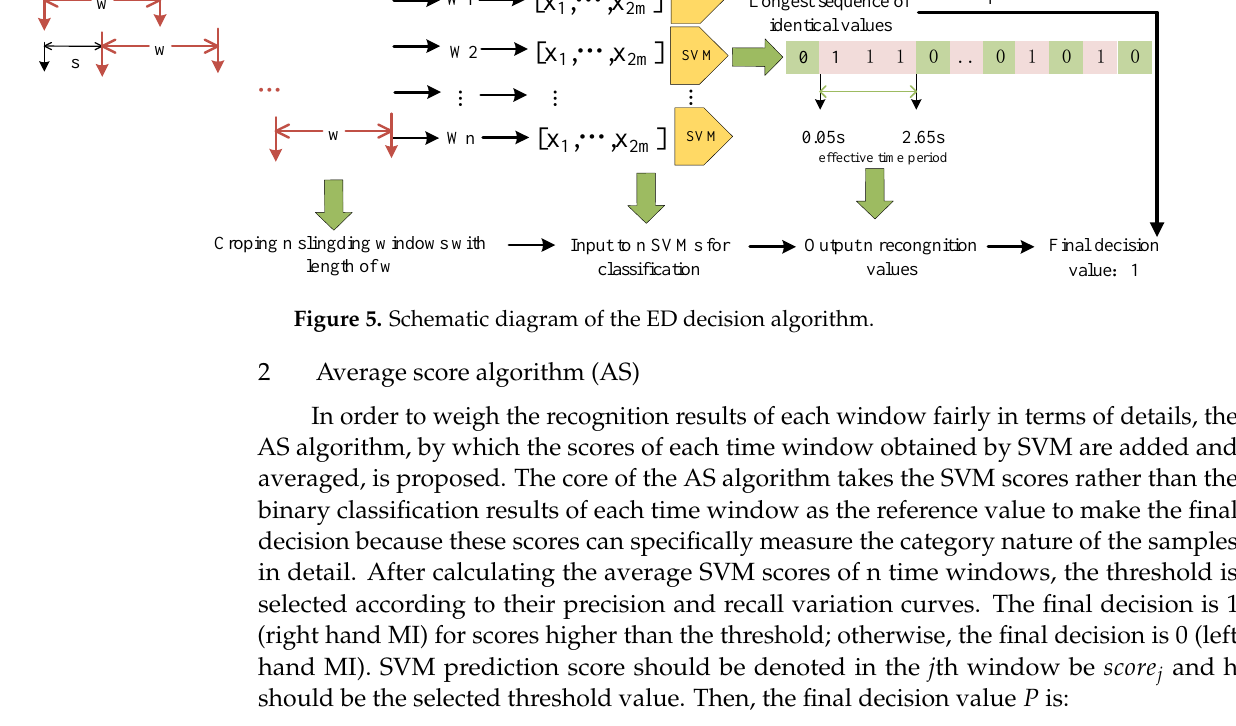
Figure 5. Schematic diagram of the ED decision algorithm.